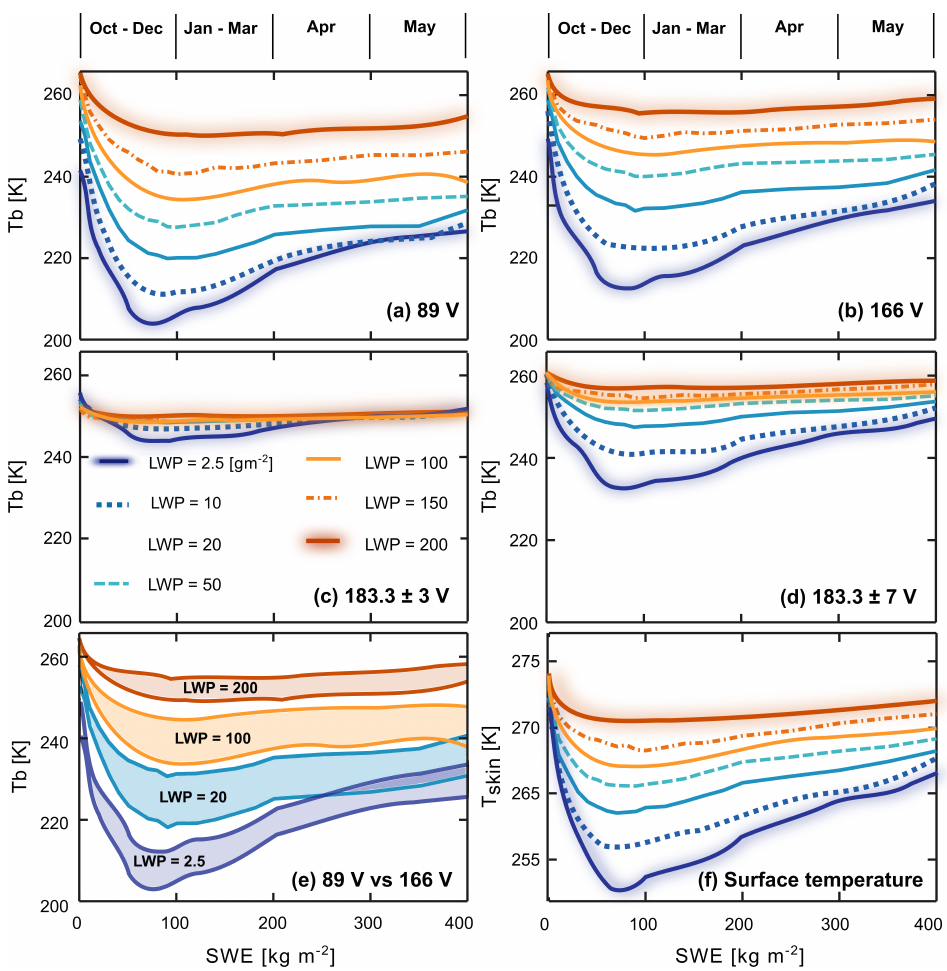
Figure 3. GMI high-frequency average Tb at channels 89V ( a ), 166V ( b ), 183 ± 3 ( c ), and 183 ± 7 GHz ( d ) as well as the comparison between the Tb values at 89 and 166GHz ( e ) and average T skin ( f ). All Tbs are for non-precipitating scenes. Furthermore, the time at the top of the TB curves is the average time of the year corresponding to the average calculated SWE